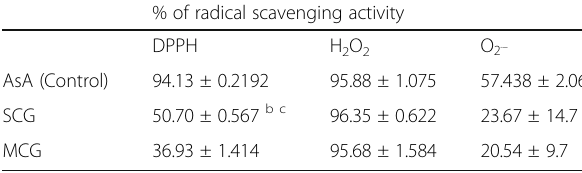
Table 1 Radical scavenging ability of SCG extracts against different oxidants a % of radical scavenging activity